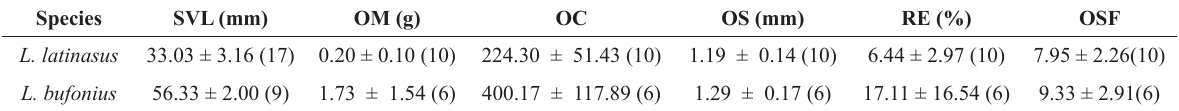
Reproductive traits of Leptodactylus latinasus and L. bufonius females . SVL = snout-vent length; OM = ovarian mass; OC = ovarian complement; OS = ovum size; RE = reproductive effort; OSF = ovarian size factor. Values are presented as Mean ± SD. Sample size is provided in parentheses.